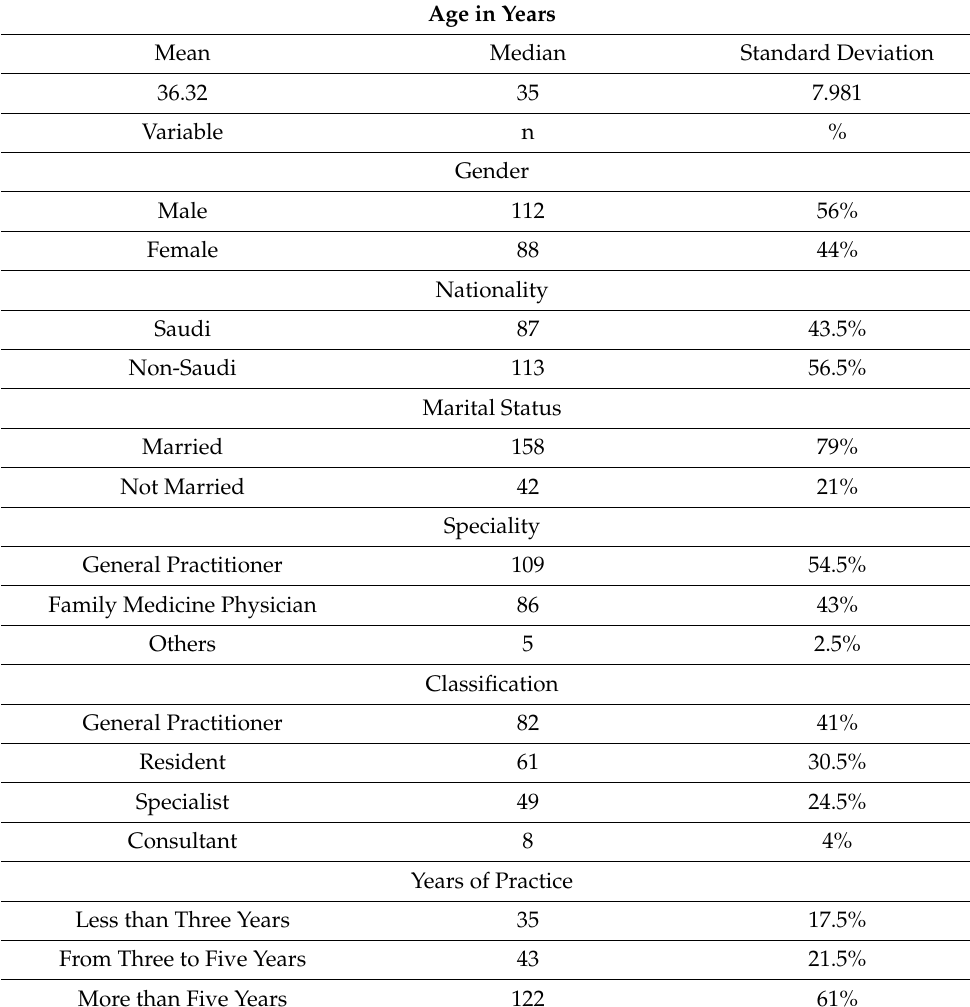
Table 1. Demographic characteristics of the participants (n =